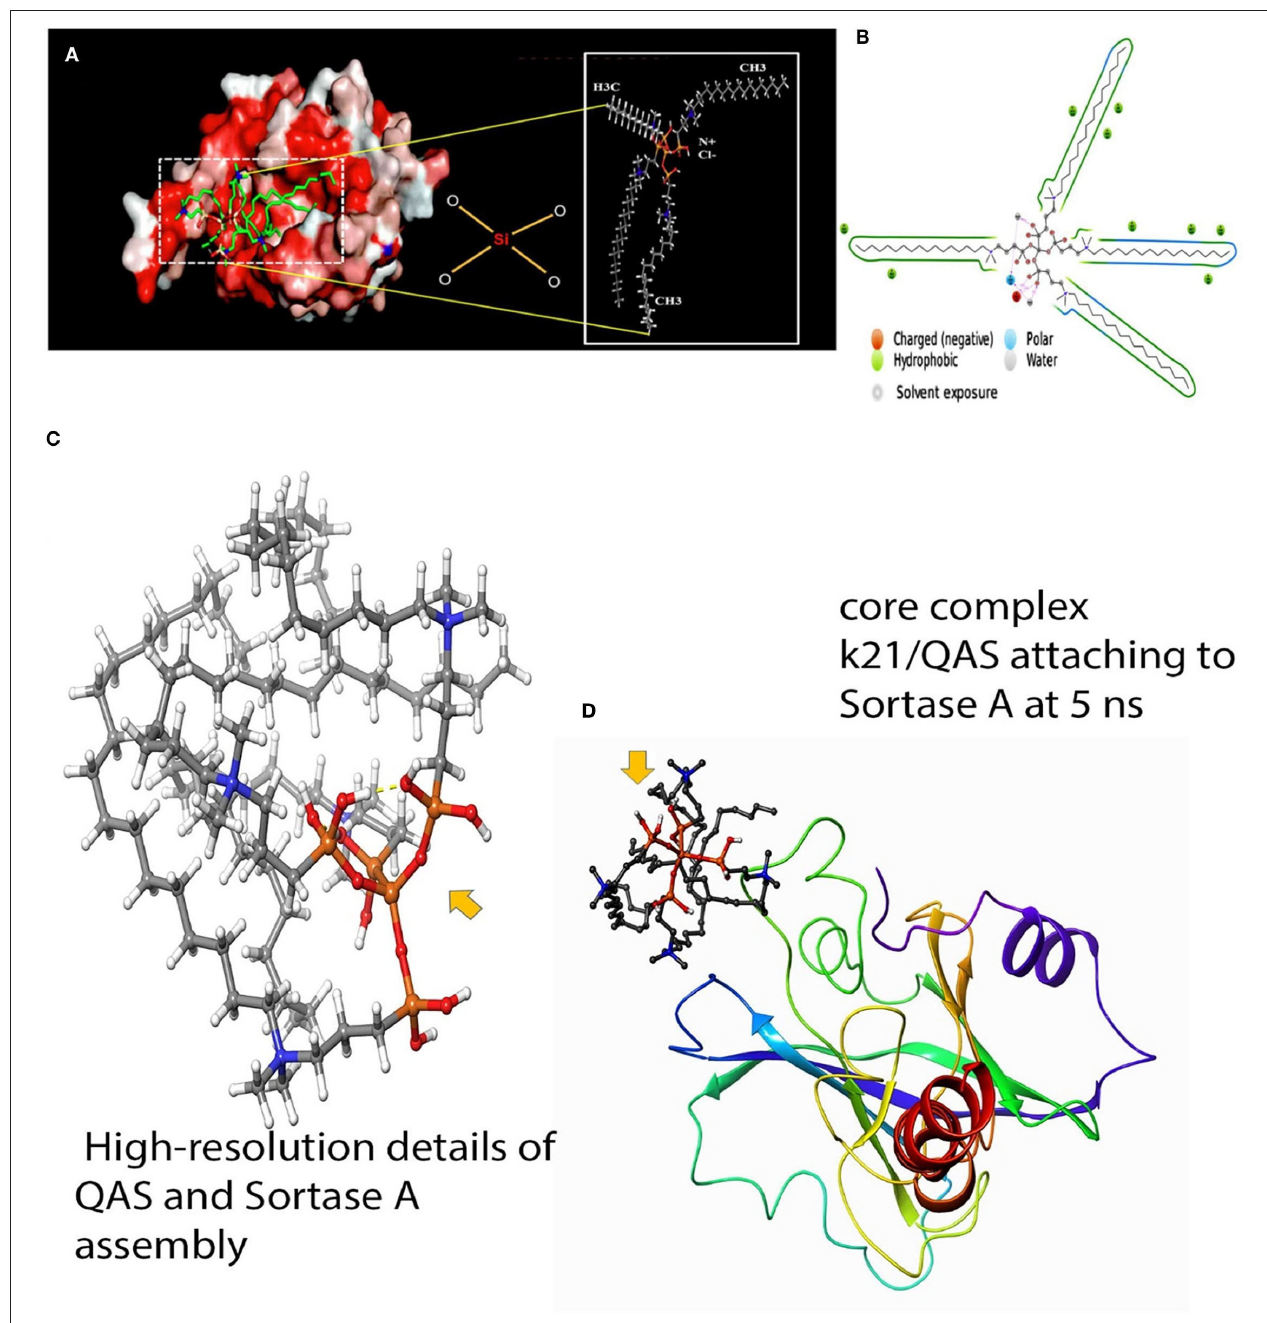
FIGURE 3 | Molecular docking of QAS and srtA. (A) Results of molecular docking simulation of QAS 1% on crystal structure of SrtA, indicating a complex predicated interaction mode of the QAS catalytic center of SrtA. The structure was generated from molecular coordinates from the Protein Data Bank, PDB ID. The subset proposed chemical formula of the QAS molecule. The docking shown in the figure is typically performed on the basis of the known Sortase-A crystal structure and the SrtA-quaternary ammonium substrate complexes. The polar capabilities of QAS have enabled it to form charge-charge interactions that can insert with the binding pocket of SrT-A. (B) A schematic of detailed ligand atom interactions with the protein residues. Interactions that occur more than 5% of the simulation time in the selected trajectory (0.00 through 100.00 ns) are shown. Reprinted from: Daood et al. (2020b). (C,D) The figure indicates a schematic detailed ligand atom interaction with the protein residues of Sortase-A with the k21 molecule. K21 attaches and interacts within nanoseconds to prevent action of srtA.